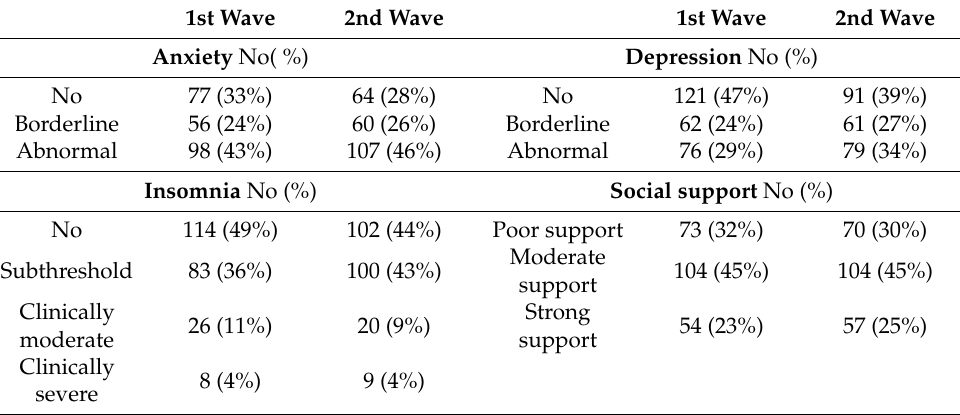
Table 3. Level of anxiety, depression, insomnia, and social support during first wave and second